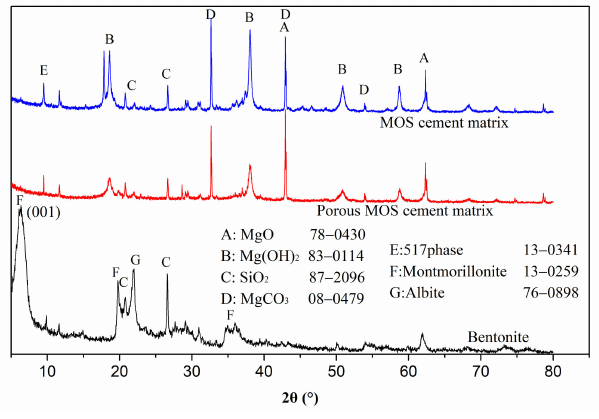
Figure 10. XRD patterns of porous MOS cement paste and cement